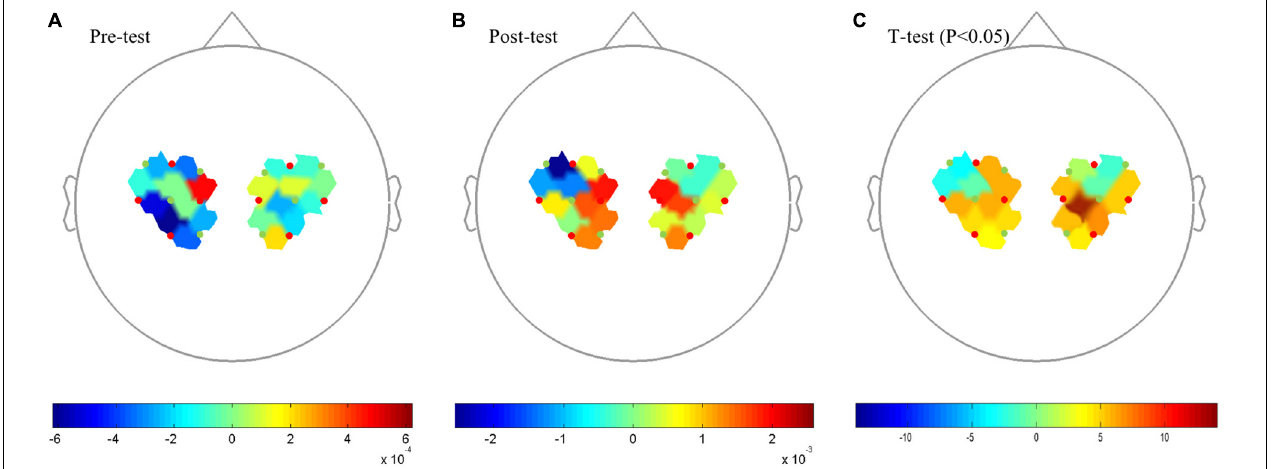
FIGURE 2 | Topography on the Beta image of Oxy-Hb concentration. (A) Pre-test Oxy-Hb concentration. (B) Post-test of Oxy-Hb concentration. (C) T -test, P < 0.05. Red points indicate sources and green points indicates detectors of the fNIRS system; When the color bar moves from 0 to 10, the larger number (red color) shows that activation became stronger ( P < 0.05).